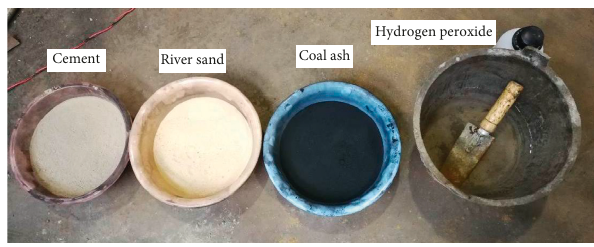
Figure 2: Rock-loose coal composite specimen (RCCS) prepared material.